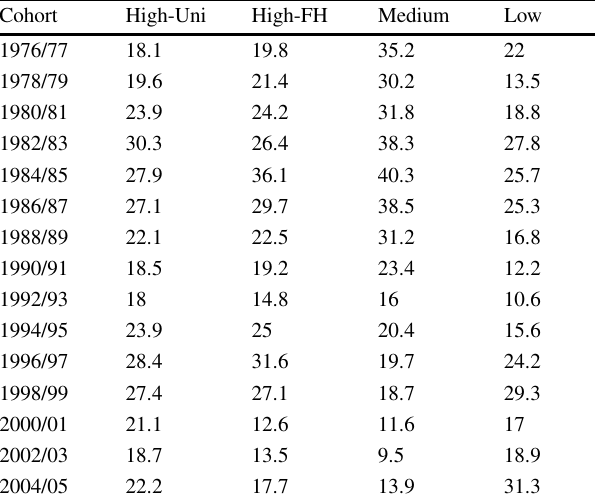
Table 1 Median Log Wage Growth for All Labor Market Entrants by Education